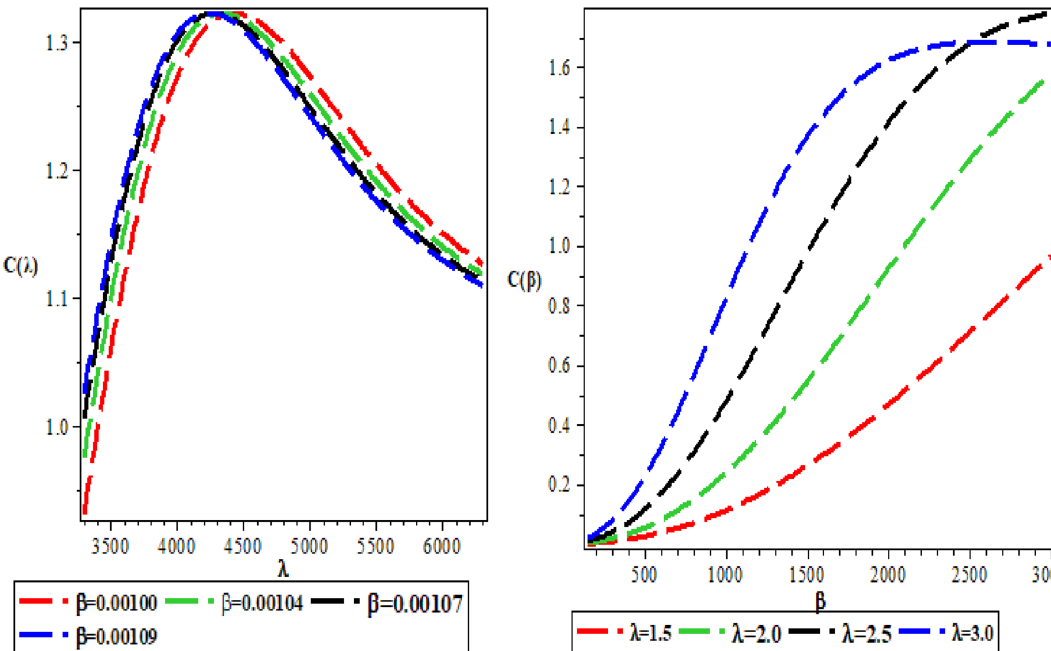
Figure 4. Variation of the vibrational specific heat capacity against the maximum quantum state (λ) and temperature parameter (β) respectively.